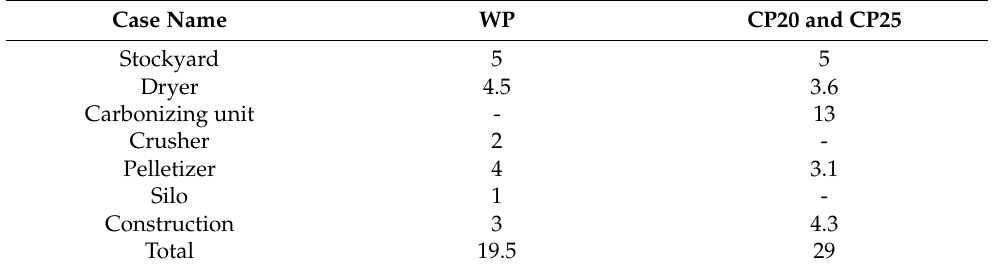
Table 2. Assumption of initial cost of facilities for WP and CP production (in million USD).